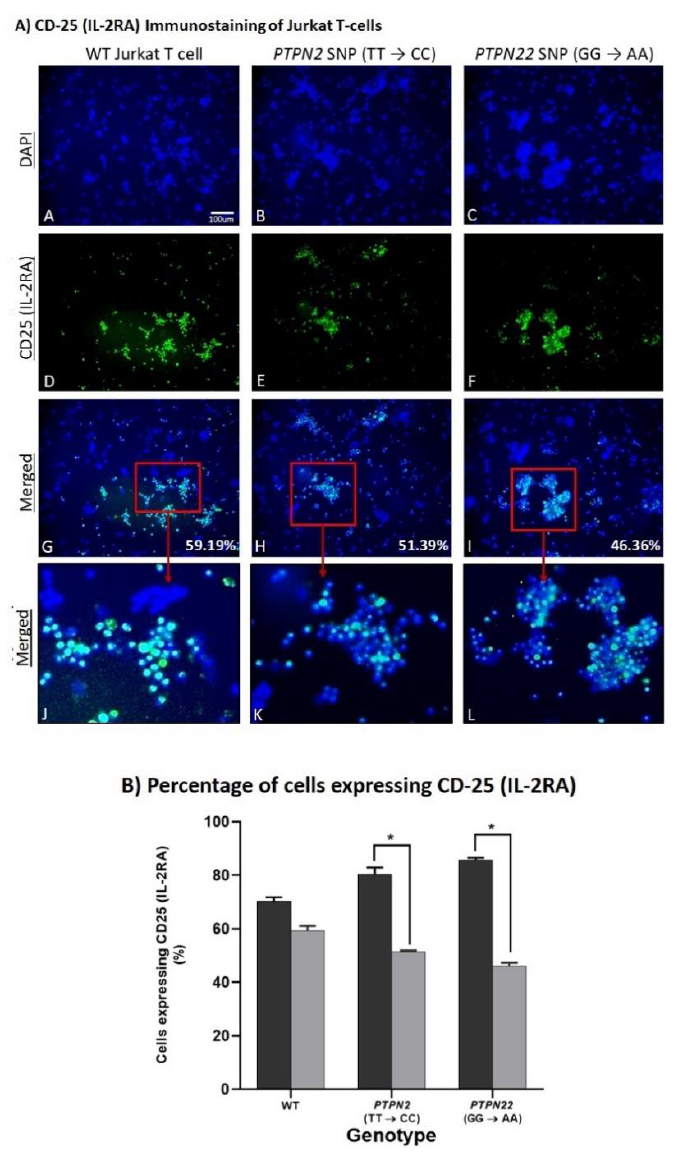
Figure 8. Effect of Spermidine on CD25 (IL-2RA) Expression in CRISPR-Cas9-edited Jurkat T-cells Stimulated with PHA. Total nuclei are stained with DAPI in blue ( A – C ). CD25 positive cells are stained in green ( D – F ), and merged cells are presented with blue and green ( G – L ). The histogram ( B ) shows percentage of cells expressing CD25 in untreated and spermidine treated (0, 10, 20 µ M) cells (WT, PTPN2 SNP, and PTPN22 SNP Jurkat T-cells). ( n = 3). * p -value < 0.05.